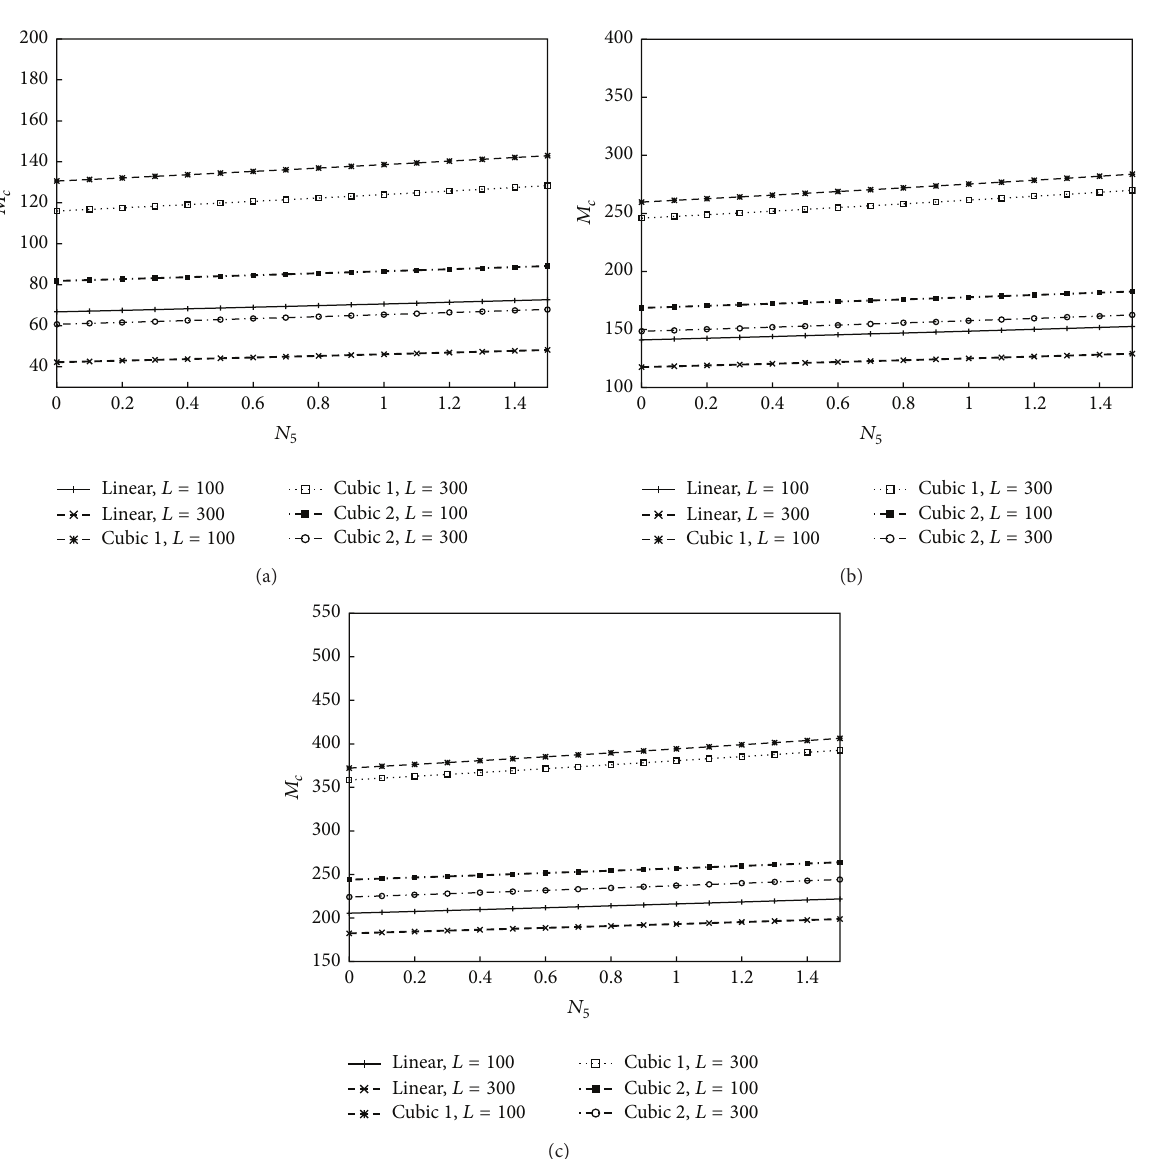
is plotted with different temperature profiles for lower rigid isothermal and upper free adiabatic boundaries. Clearly, 𝑀